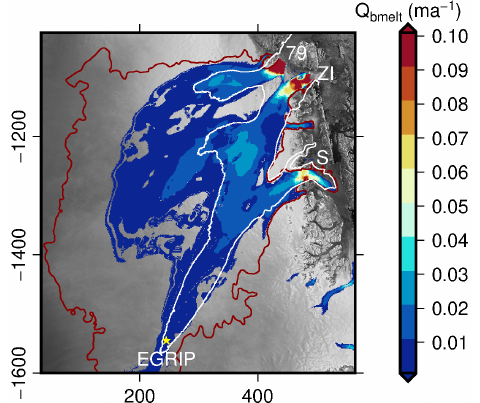
Figure 7. Boundary conditions and forcing for the NEGIS exper- iment. The basal melt rate from PISM and the contour line for (cid:50) pmp = − 0 . 1K (red) used as a model boundary are shown. The white line indicates the 50ma − 1 velocity contour.